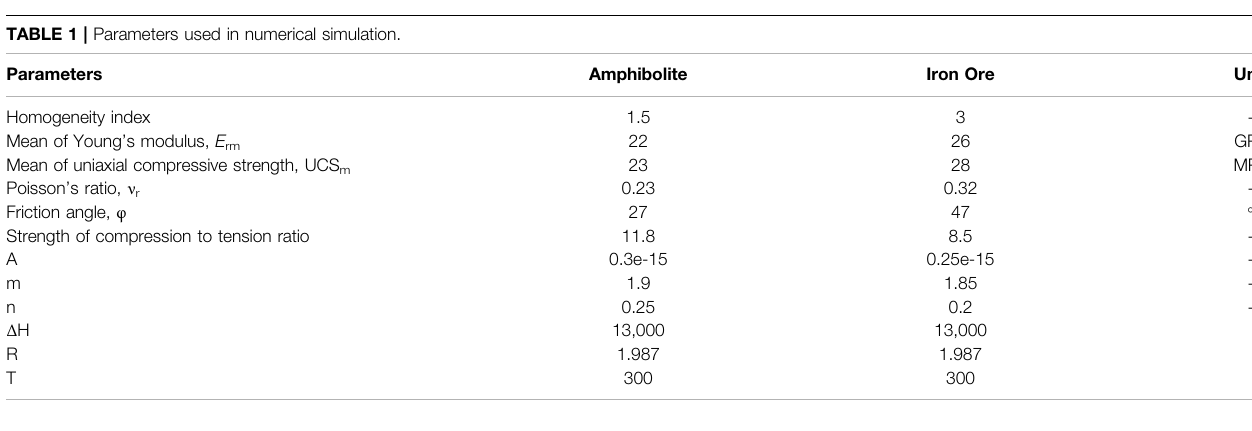
TABLE 1 | Parameters used in numerical simulation.